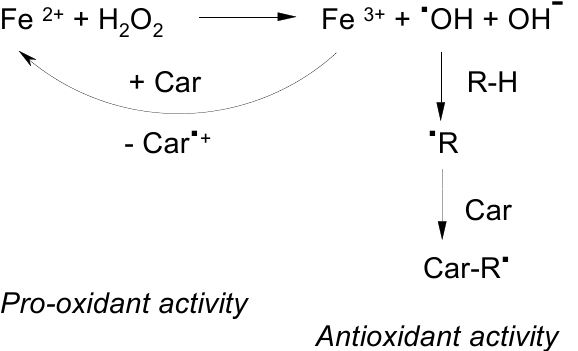
Figure 3. The suggested mechanism of the antioxidant and pro-oxidant activity of carotenoids in the presence of Fe ions [21].